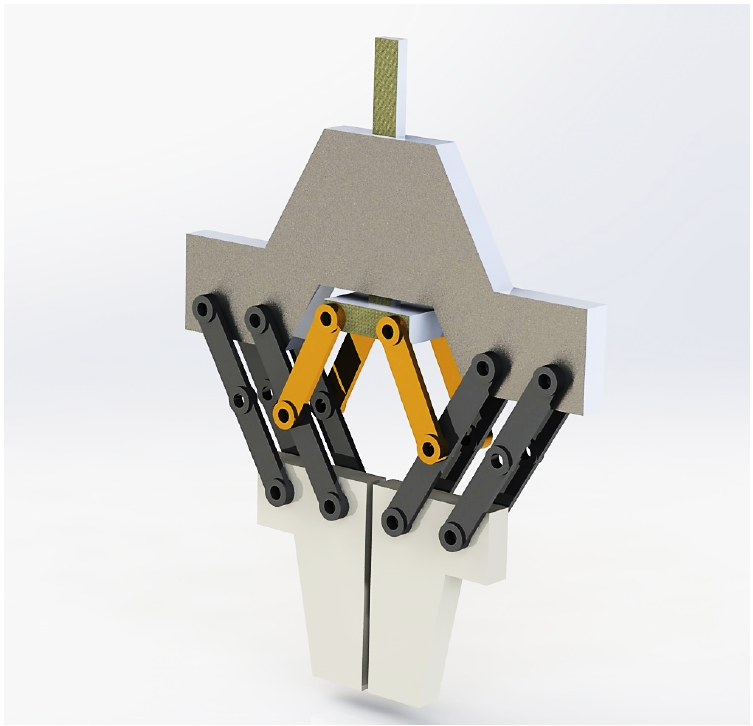
Figure 2. Gripper 3d